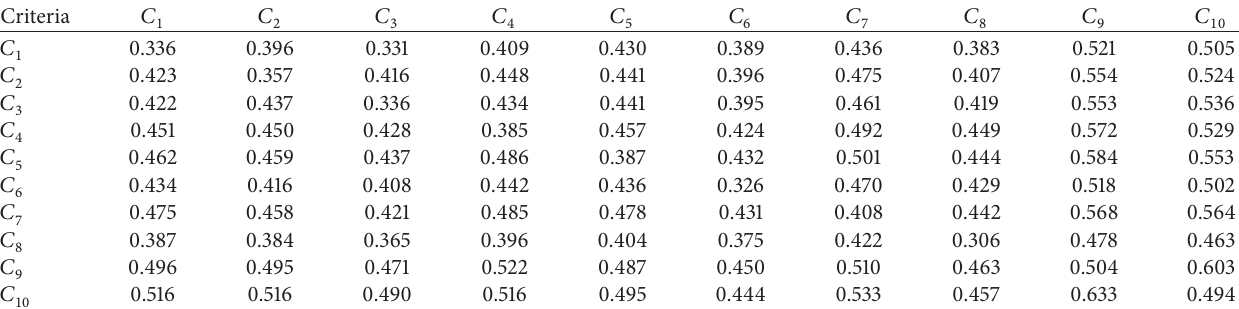
Table 3: The total influence matrix T .